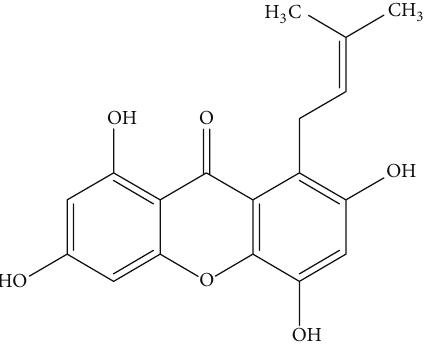
Figure 1: Chemical structure of